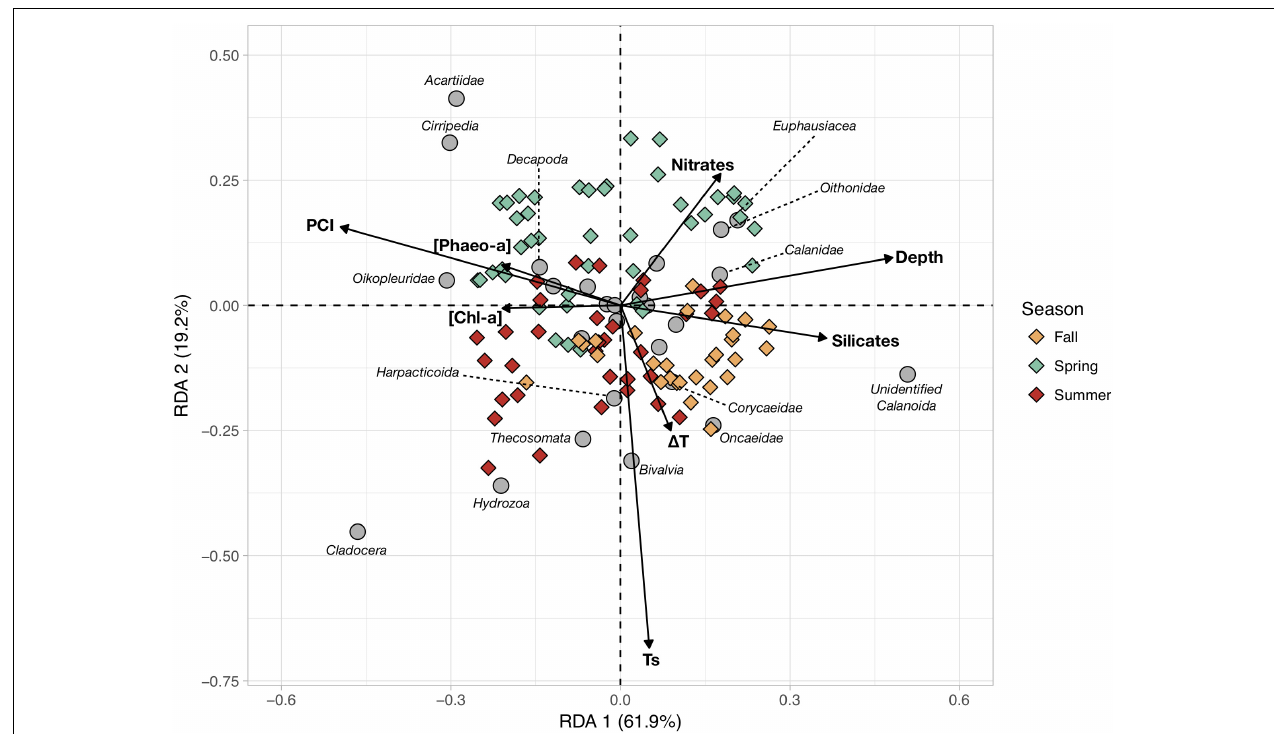
FIGURE 5 | Redundant Discriminant Analysis (RDA) based on the Hellinger-transformed abundances of the main mesozooplankton groups (response variables) and the measured hydrobiological data (explanatory variables, arrows). The color of the symbols corresponding to sampling stations (objects) were colored according to sampling season (Spring, Summer, and Fall).